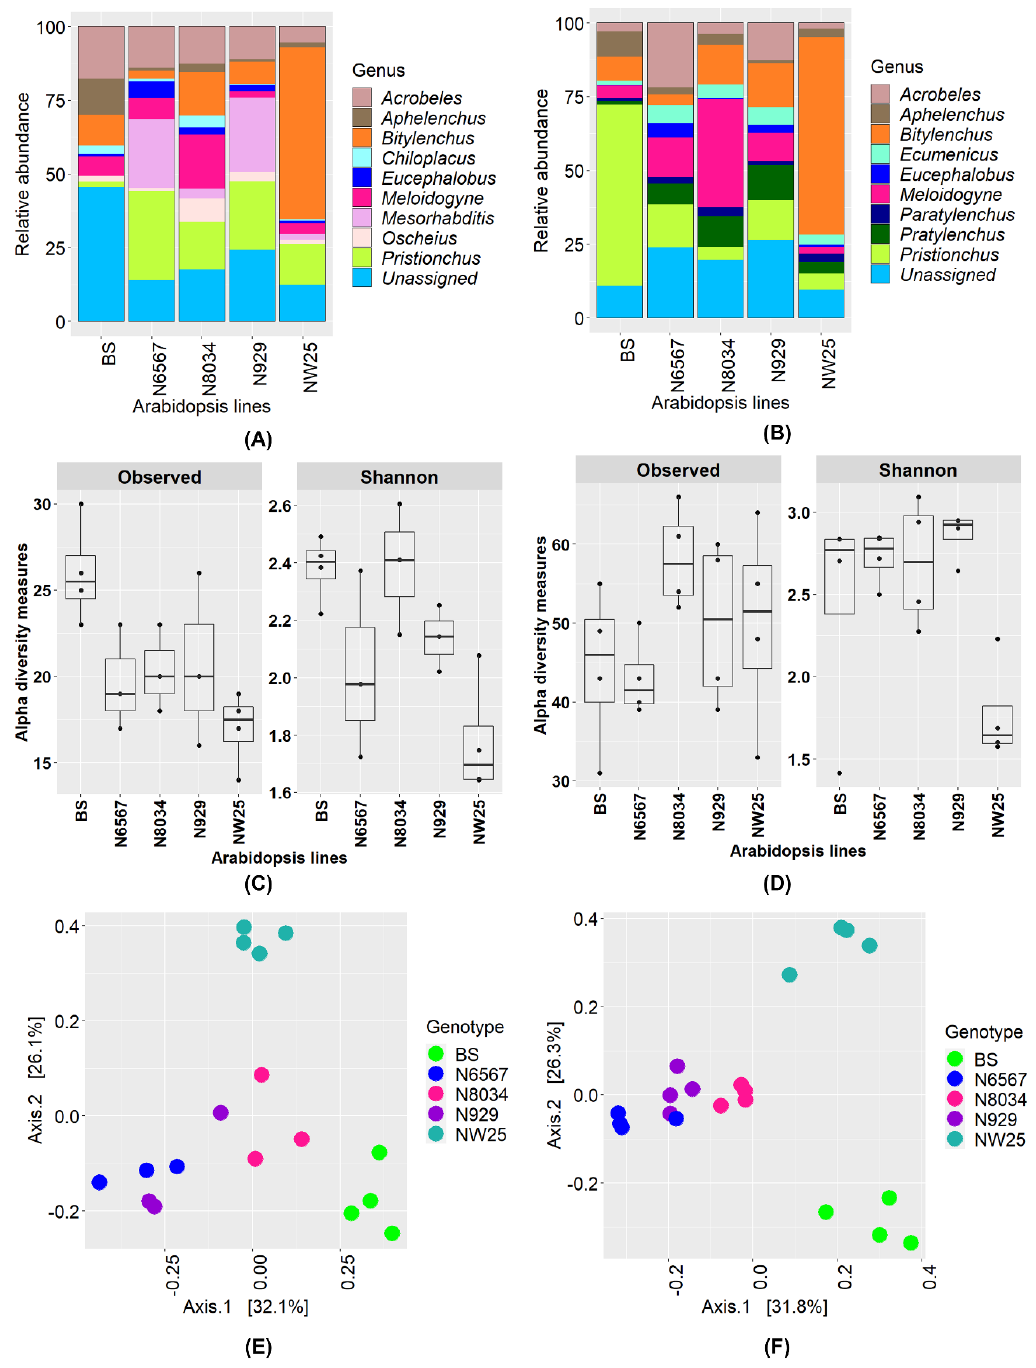
Figure 3. Comparison of nematode taxonomic profiles from the roots of di ff erent Arabidopsis accessions (N6567, N8034, N929, and NW25) and unplanted bulk soil (BS) amplified using MMS: MMSF / MMSR ( A , C , E ) and NEM: Nemf / 18Sr2b ( B , D , F ) primer sets. ( A , B ) Relative abundance of the ten most abundant genera are shown. ( C , D ) The alpha diversity was estimated using observed operational taxonomic unit (out) richness and Shannon diversity indices. ( E , F ) Principal Coordinates Analysis (PCoA) ordination plot using Bray–Curtis distance